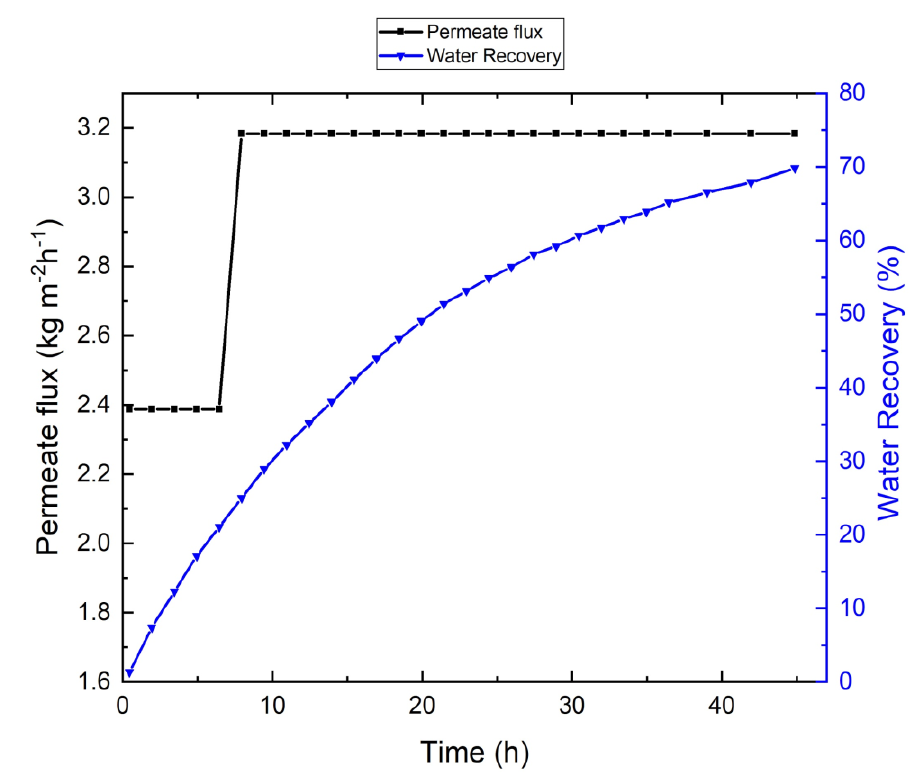
Figure A4. Permeate flux and water recovery as functions of time when using an aqueous NaCl solution as feed.